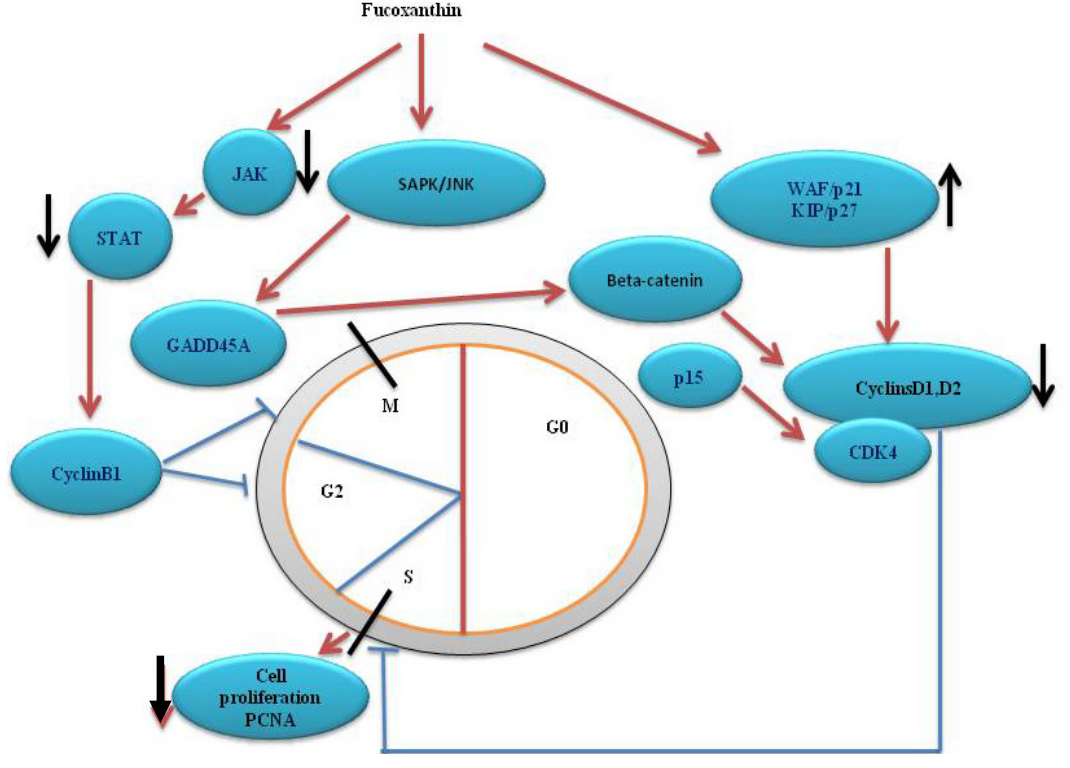
Figure 3. Fucoxanthin on cell cycle arrest. ↑ Up regulation; ↓ down